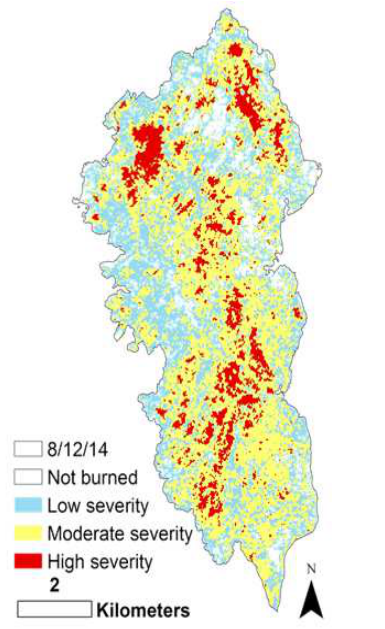
Figure 1. Soil burn severity map of the French Fire